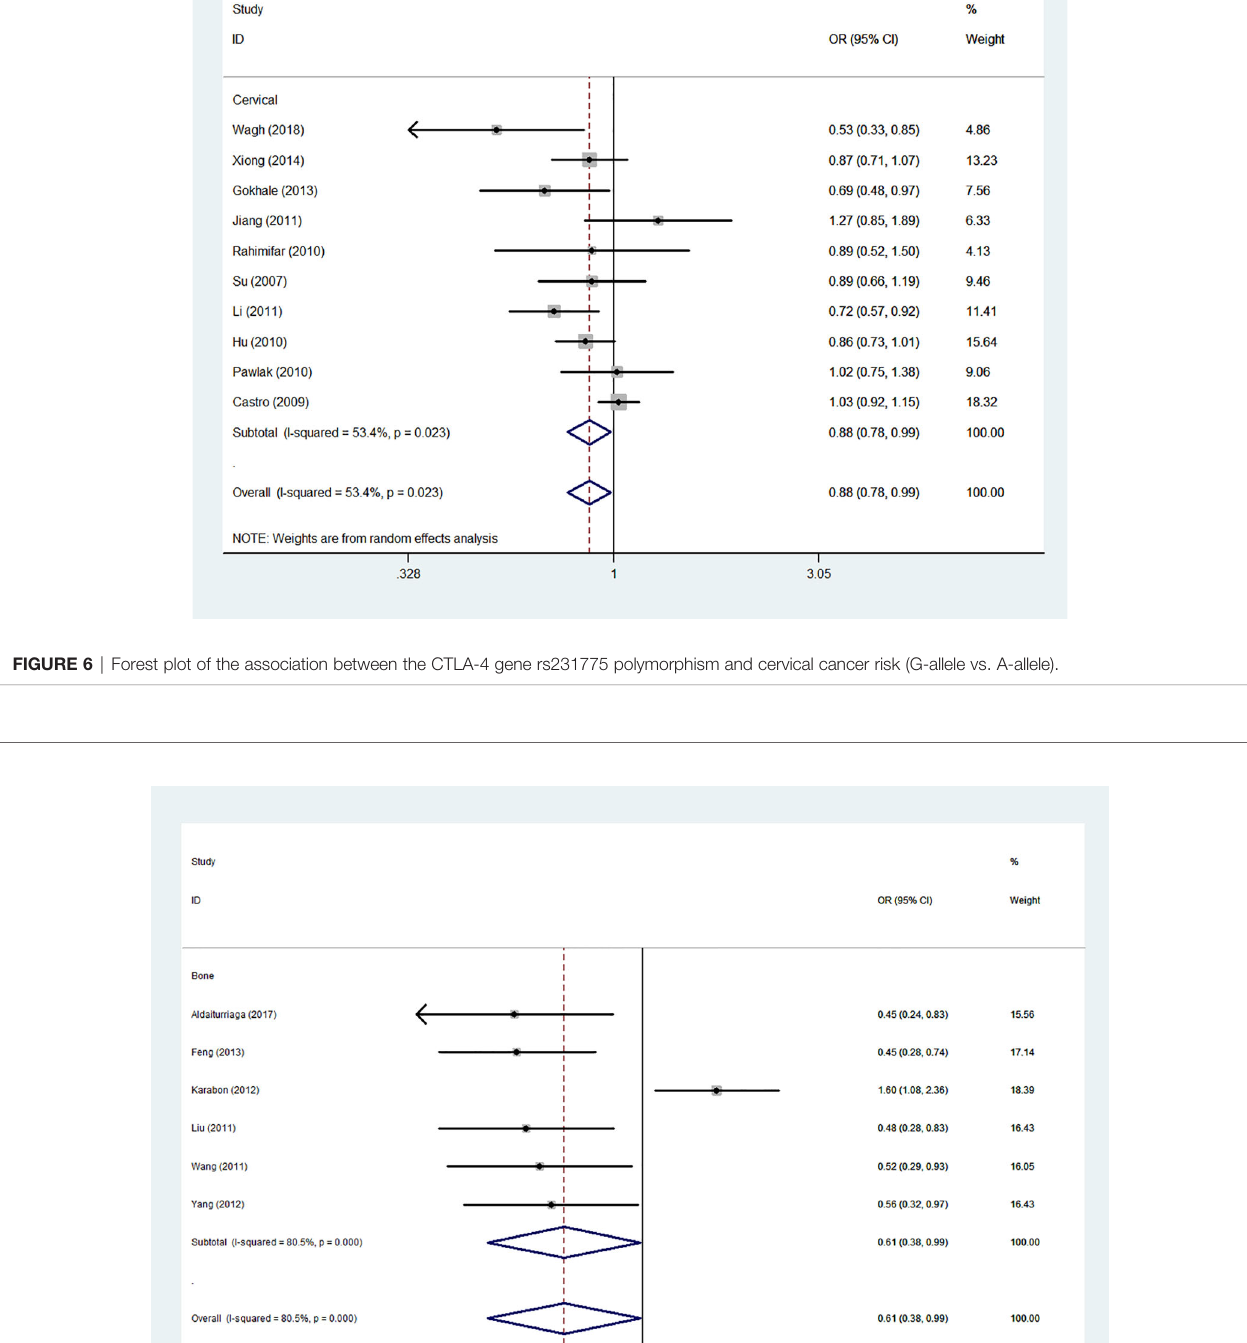
Frontiers in Oncology |